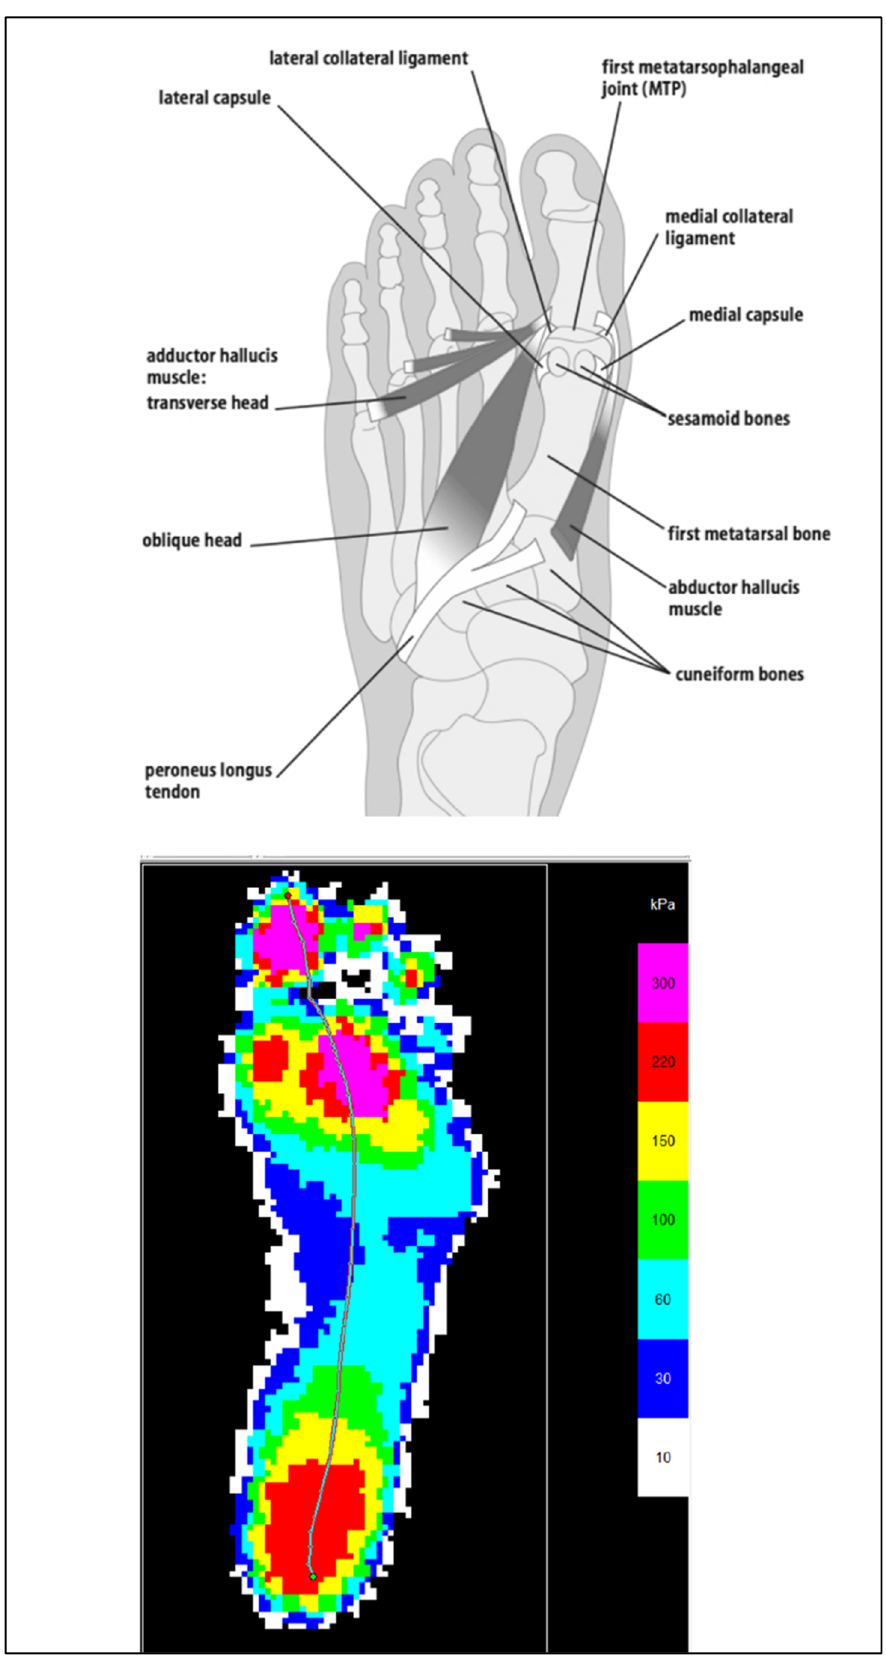
Figure 12. Result from E-med Pressure platform.